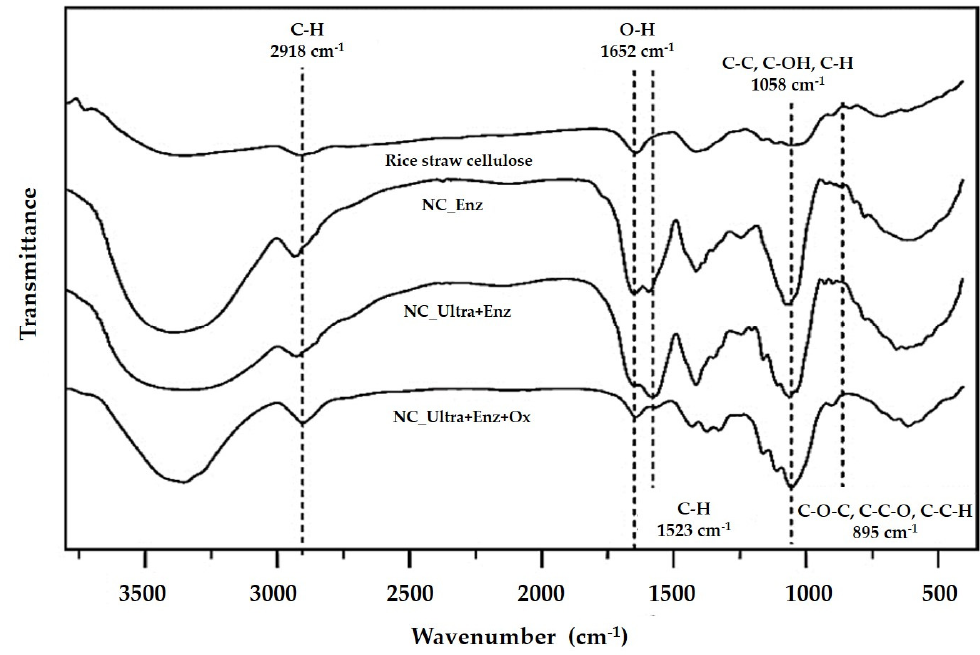
Figure 6. FTIR spectra of rice straw cellulose and nanocelluloses prepared by the integrated biobased approaches; enzymatic hydrolysis (NC_Enz), ultrasonication prior to enzymatic hydrolysis (NC_Ultra + Enz), and intensification by oxalic acid hydrolysis (NC_Ultra + Enz + Ox).